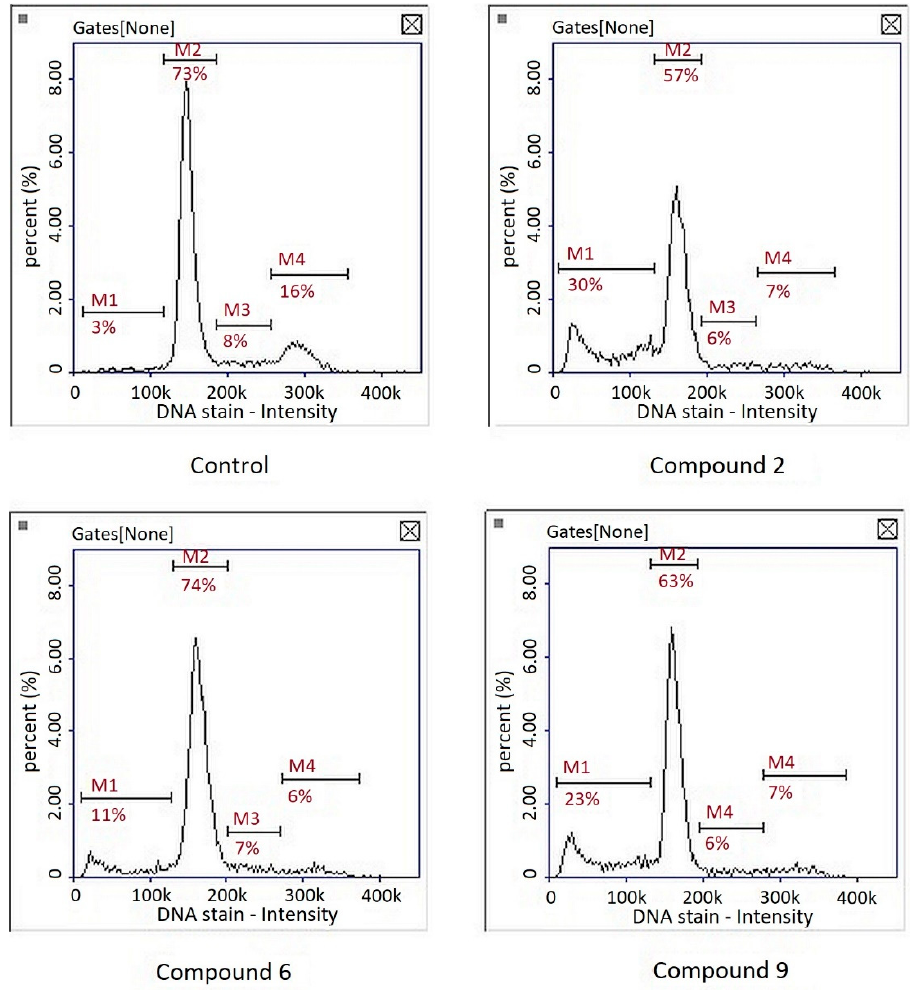
Figure 6. Representative histograms of cell cycle analysis in cultures of melanoma line G-361 after 24 h treatment with compounds PK2, PK6 and PK9 in concentrations corresponding to appropriate IC 50 values or DMSO as a vehicle in control culture using image cytometry. M1, subG1 phase (apoptotic cells); M2, G1 phase; M3, S phase; M4, G2/M phase. Reduced glutathione is one of the most important small-molecule free radical scav- engers. Under oxidative stress conditions, the level of GSH in the cell decreases, which is converted to its oxidized form, GSSG [32]. Image cytometry analysis revealed decreased GSH levels in cells treated with all tested compounds, which indicates that they disrupted the redox balance (Figure 7)